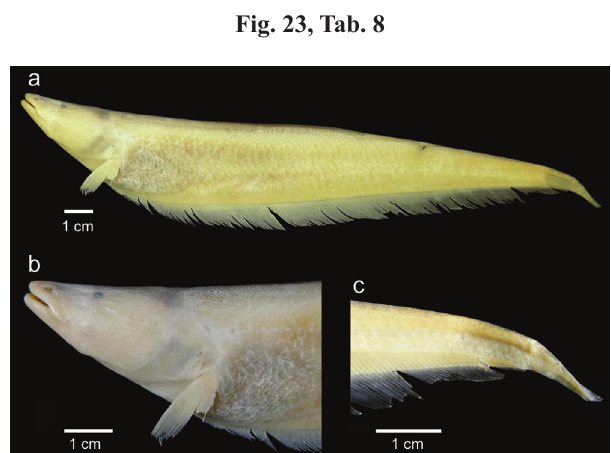
Fig. 23. Sternarchella raptor (ANSP 200511). a. Lateral view of the body, b. Lateral view of the head, c. Lateral view of the caudal region. Scale bars = 1 cm.